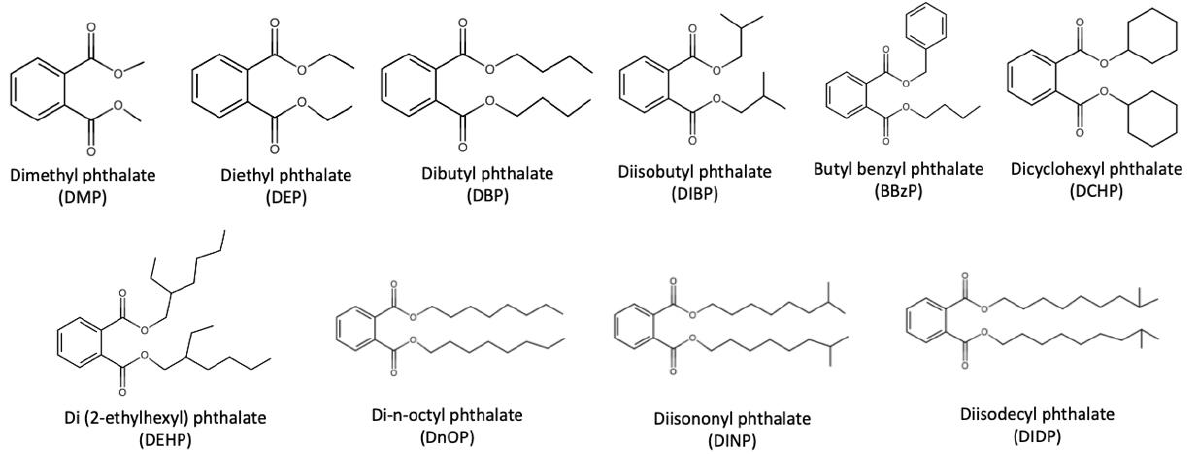
Figure 1. Ten widely used phthalates as summarized by Wang et al. [6].